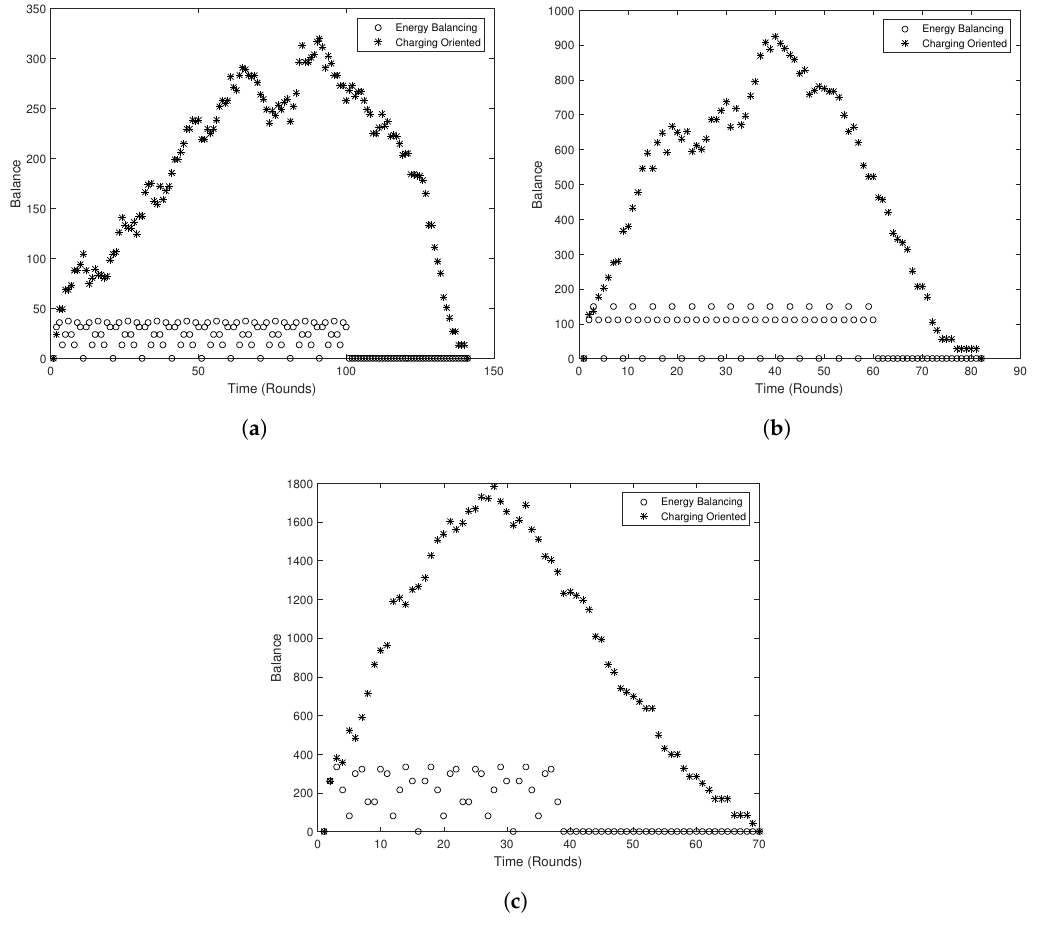
Figure 6. Energy balance over time for ( a ) 10, ( b ) 20 and ( c ) 30 chargers